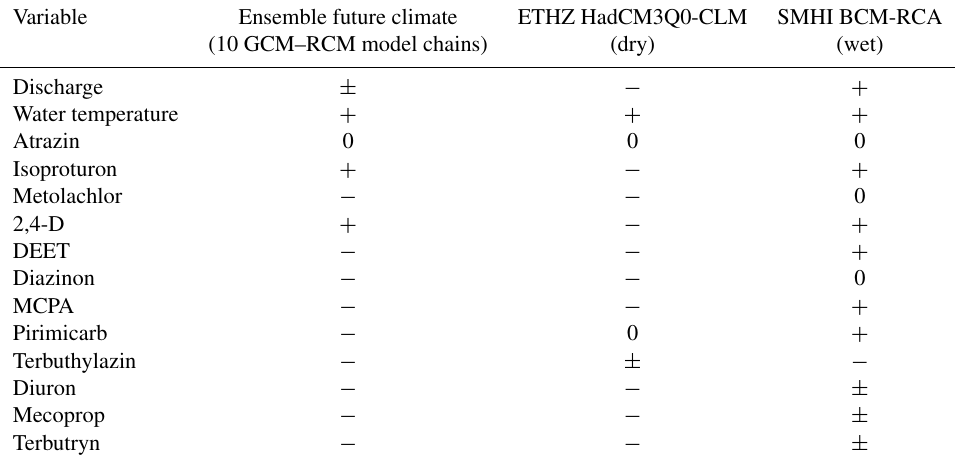
Table 4. Signs of change for future physical parameters and micropollutant concentrations considering climate change only (assuming status quo + CurrPrac), derived from a figure similar to Fig. 4. + : general increase (none of Q2.5%, Q50%, and Q97.5% decreased); − : general decrease (none of Q2.5%, Q50%, and Q97.5% increased); ± : quantile-specific response (at least a pair out of Q2.5%, Q50%, and Q97.5% changed in different directions); 0: no change.